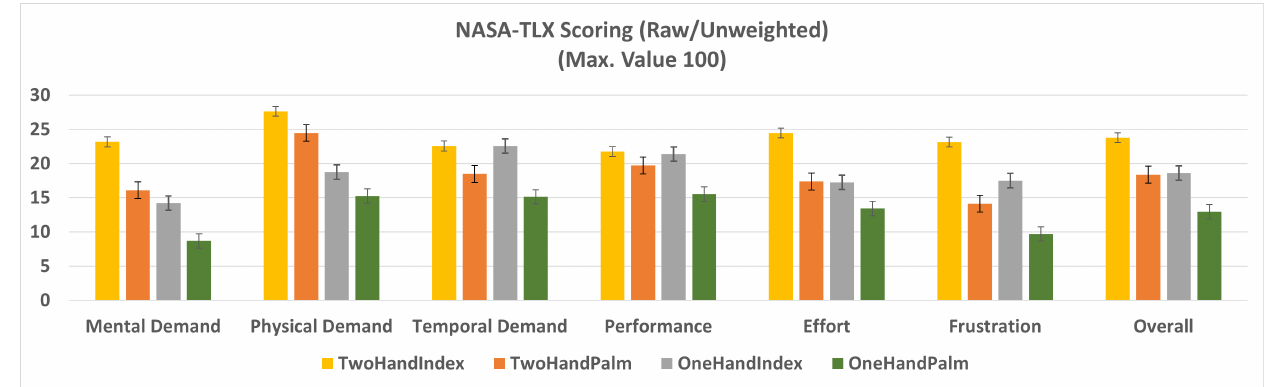
Figure 13. Raw NASA Task Load Index (NASA-TLX) scores for each proposed locomotion technique. Lower numbers are better and the maximum value of a subscale is 100.